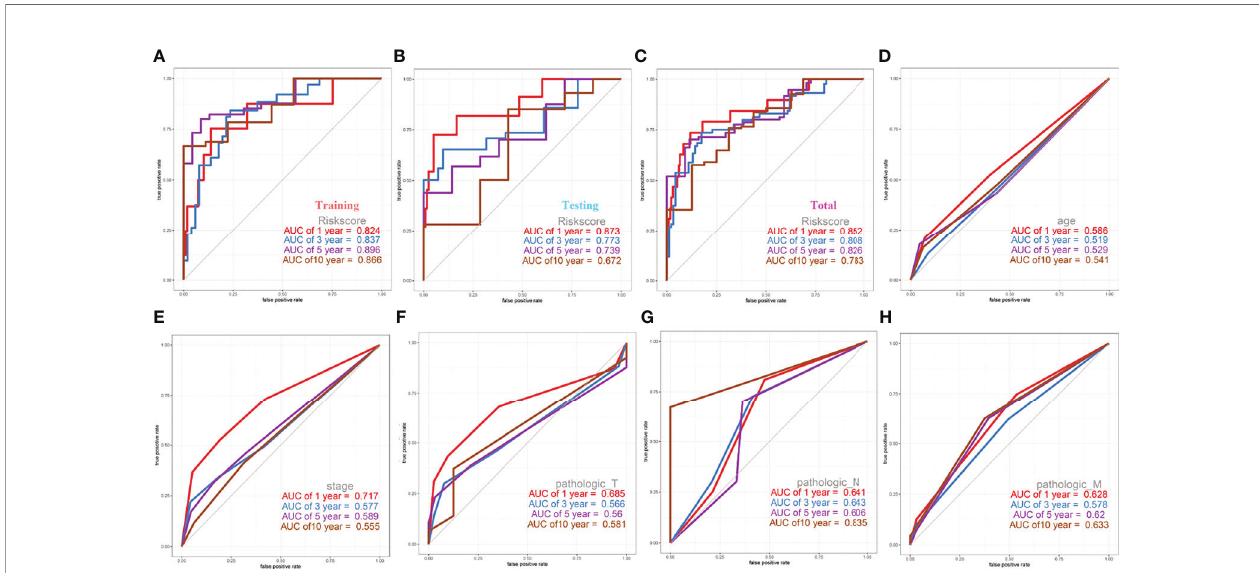
FIGURE 7 | ROC Curves of OS for this prognostic model. (A) training set, (B) testing set, (C) entire set, (D) age, (E) stage, (F) pathologic_T, (G) pathologic_N, (H)